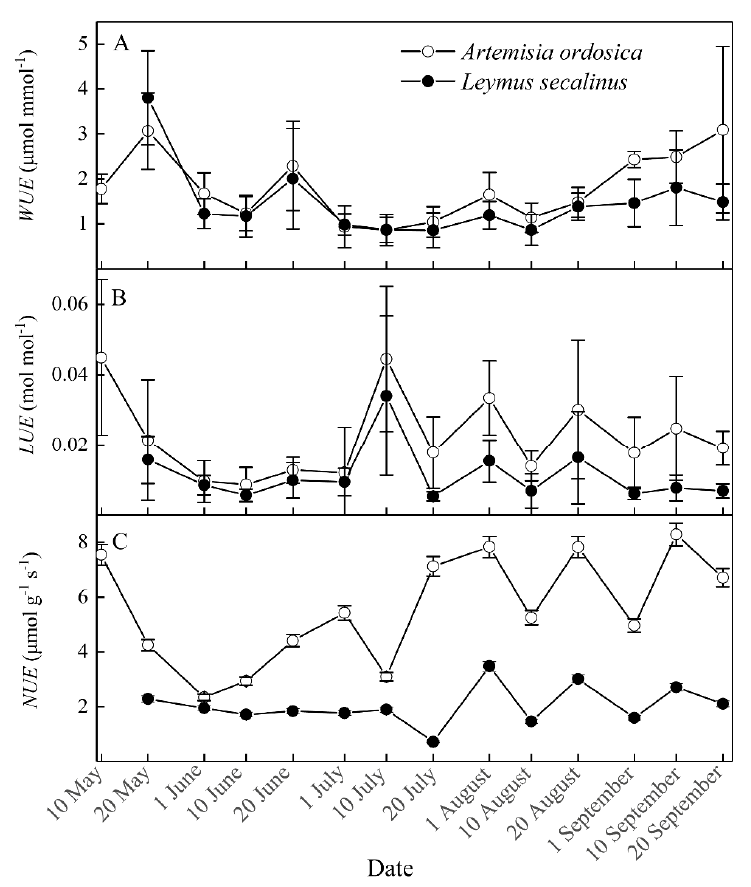
Figure 5. Seasonal changes in water ( A ), light ( B ), and nitrogen use efficiencies ( C ) (i.e., WUE , LUE , and NUE ) in A. ordosica and L. secalinus . Bars indicate standard error of estimate.